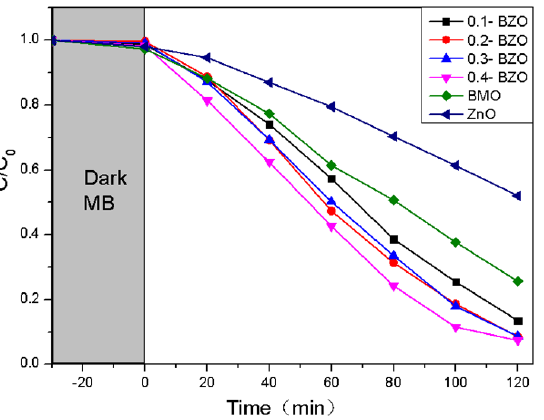
Figure 9. The photocatalytic activity of BMO, ZnO, and X-BZO in 10 mg/L MB dye.